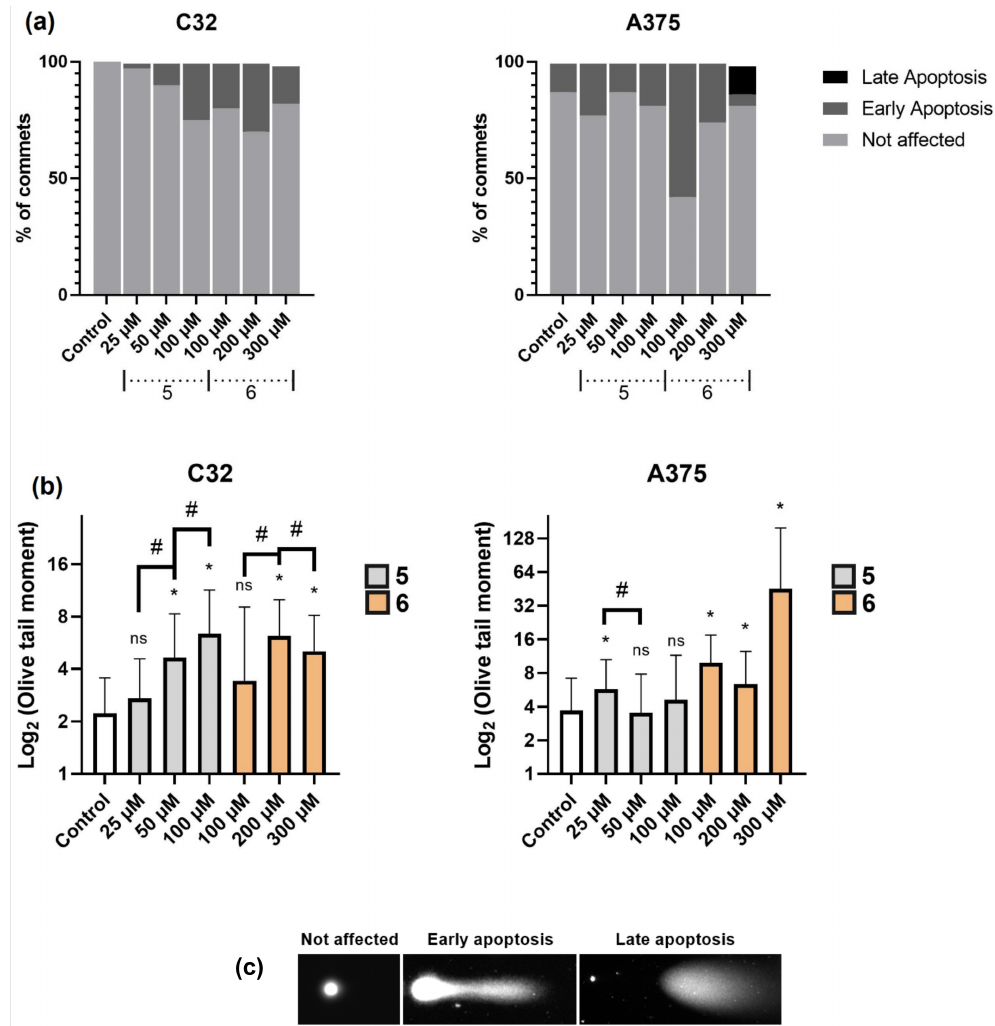
Figure 6. Cell death evaluation by the neutral comet assay results for human melanoma cells: ( a ) A cell death evaluation by the following scoring: not affected; early apoptosis; late apoptosis, the scoring method based on Cortes-Gutierrez [51]; ( b ) Olive tail moment (OTM), which corresponds to the product of the tail length and the fraction of total DNA in the tail; ( c ) An exemplary representation of comets used for scoring. ns—not significant, # p < 0.05 significant in comparison to adjacent data, * p < 0.05 significant in comparison to